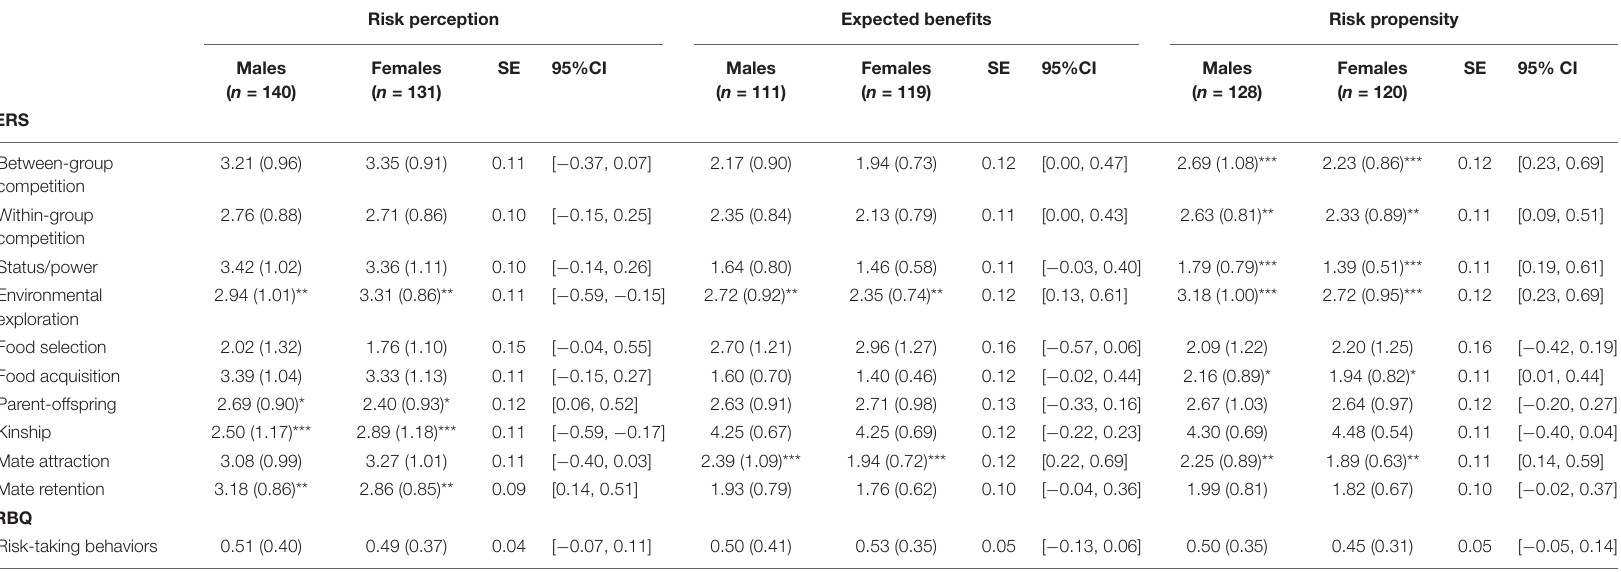
TABLE 3 | Statistic descriptives and sex differences between risk contexts in the ten evolutionary domains and risk-taking behaviors. Risk